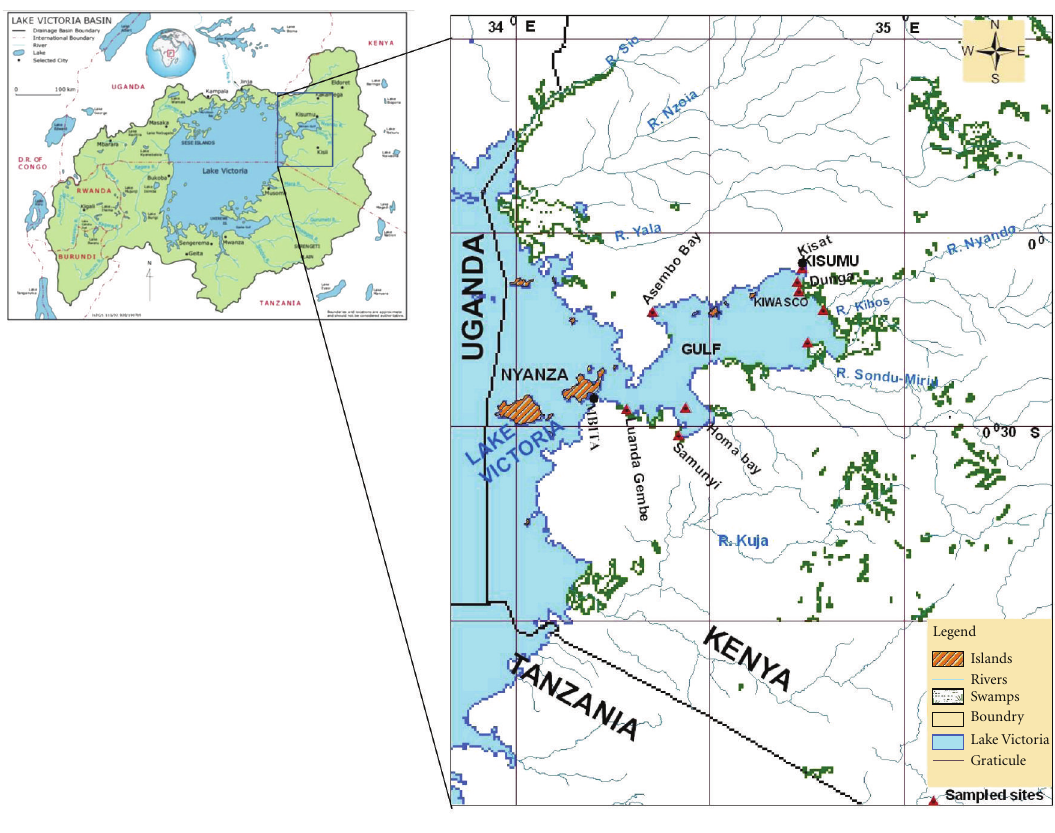
Figure 1: Map of the Nyanza Gulf, Lake Victoria showing the sampling